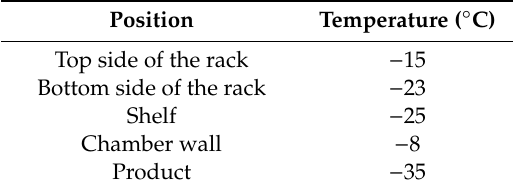
Table 2. Temperatures of rack, product, and chamber wall during primary drying.